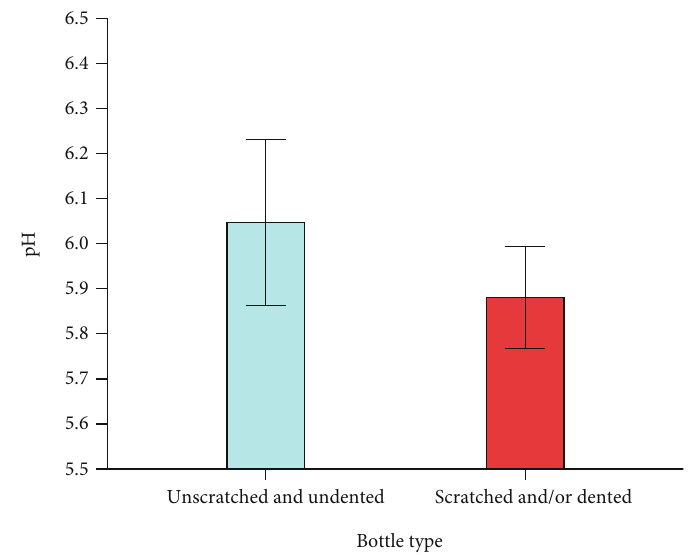
Figure 1: Distribution of the pH value with respect to the physical condition of the bottled water